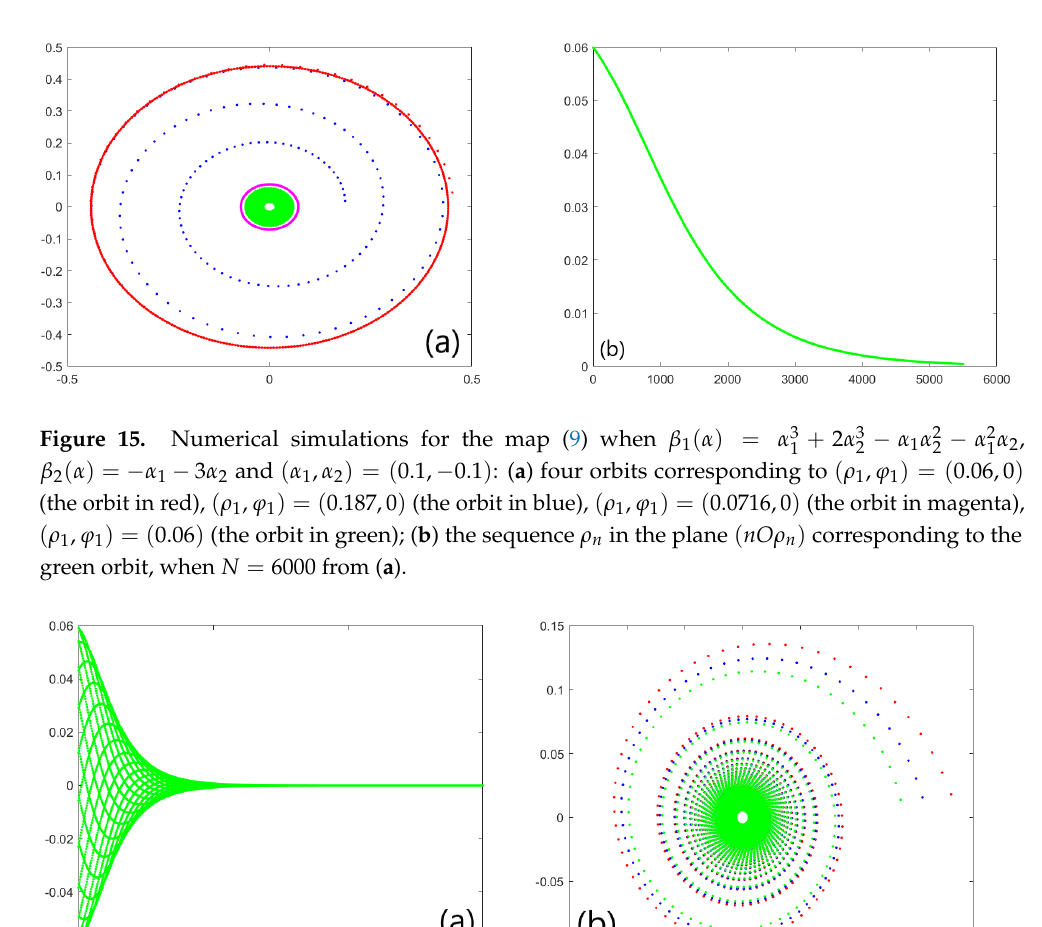
Figure 16. Numerical simulations for the map (9): ( a ) sequence x n in the plane ( nO ρ ) from Figure 15b; ( b ) numerical simulations for the map (9) when β 1 ( α ) = 2 α 3 − α − α 2 β 2 ( α ) = − α 2 , ( α 1 , α 2 ) = ( 0.9, − 0.9 ) and ( ρ 1 , ϕ 1 ) ( 0.183,0 ) (red orbit), 1 α 2 2 1